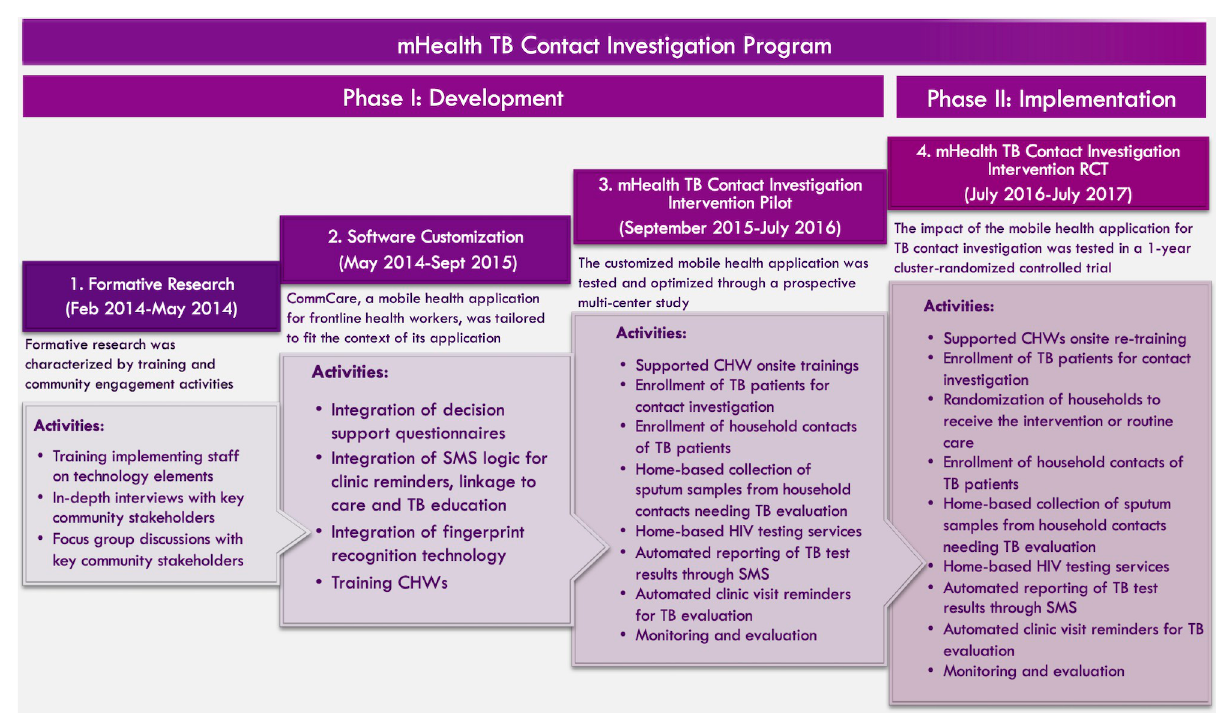
Fig 1. A detailed description of program activities in the different phases of